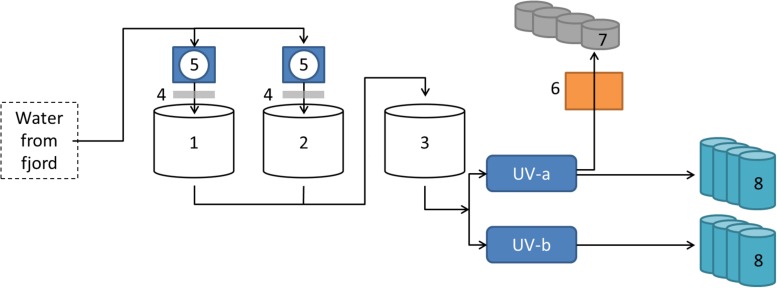
Overview of intake water at the Vest Aqua Base. Water originated from ∼70 m depth in the adjacent bay, and was stored in three land-based tanks (1–3). Storage tank 1 and 2 were also connected to degassing columns (4) and drum filters (5). The water was disinfected by UV treatment in two pipe lines (UV-a and UV-b) before entering the facility. A separate line had an additional sand filter (6) before entering the hatchery (7). Water from both UV-treated pipe lines supplied parallel fish tanks in the weaning- and on-growing sections (8).